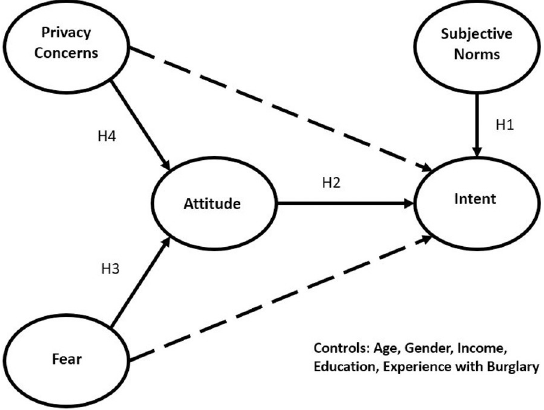
Fig 1. TRA model of intent to purchase IoT home security